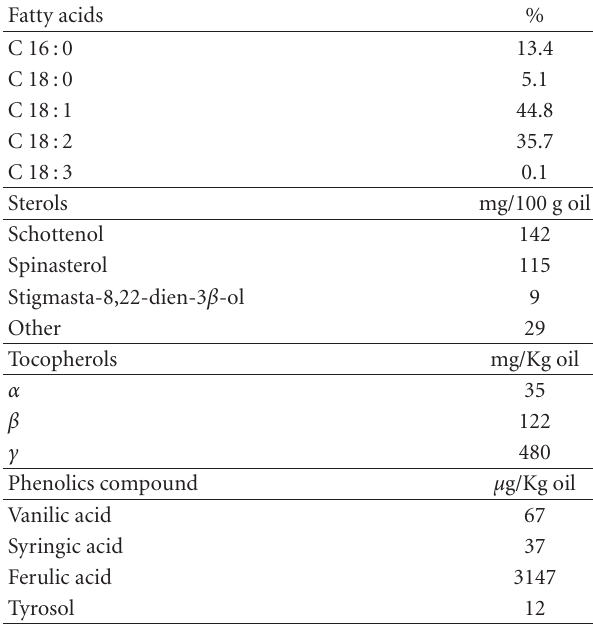
Table 1: Chemical composition of argan oil